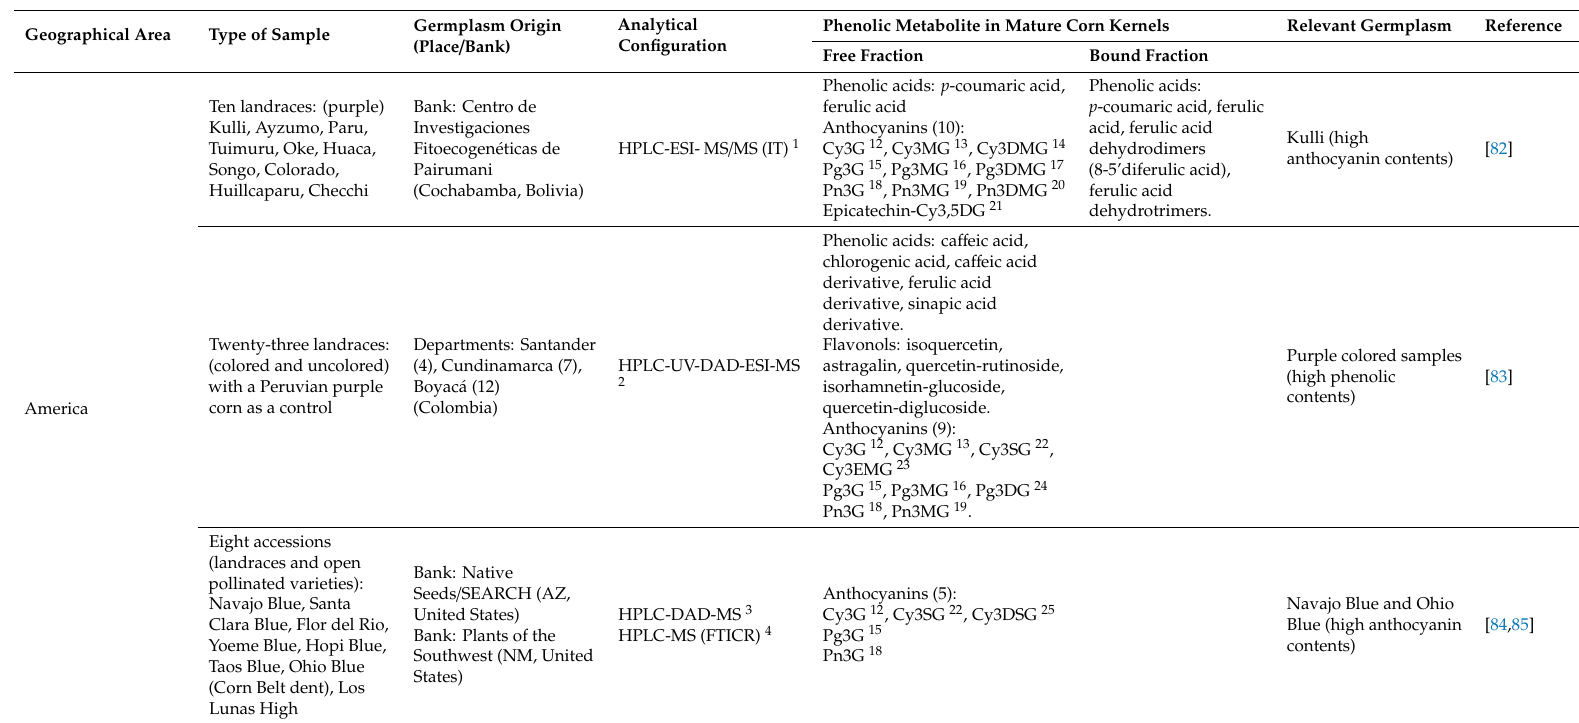
Table 2. Targeted metabolomics using liquid chromatography mass spectrometry (LC-MS) platforms for the characterization of phenolic bioactive compounds in worldwide corn